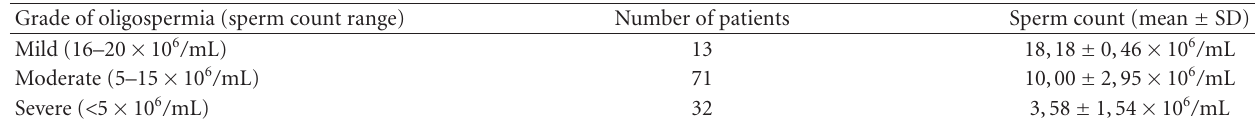
Table 3: Stratification of the patients with reduction in sperm count according to the grade of oligospermia. Grade of oligospermia (sperm count